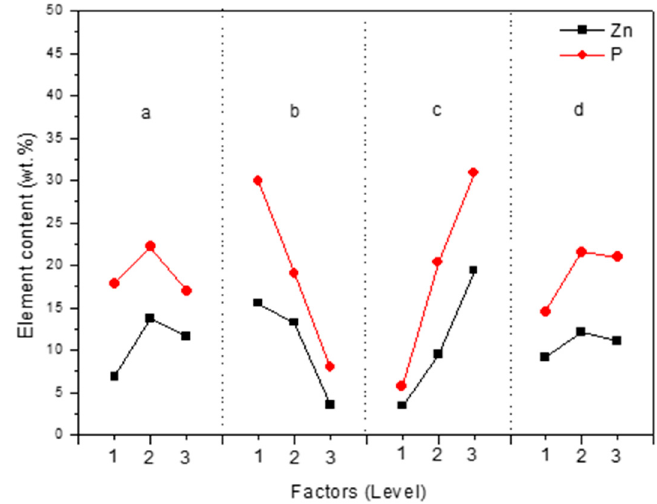
Figure 3. Effects of factors on the content of Zn and P elements in anodic coatings: ( a ) EDTA-ZnNa 2 concentration; ( b ) KOH concentration; ( c ) phytic acid concentration; ( d ) treating time.